Question: Author a descriptive caption for the visualization shown.
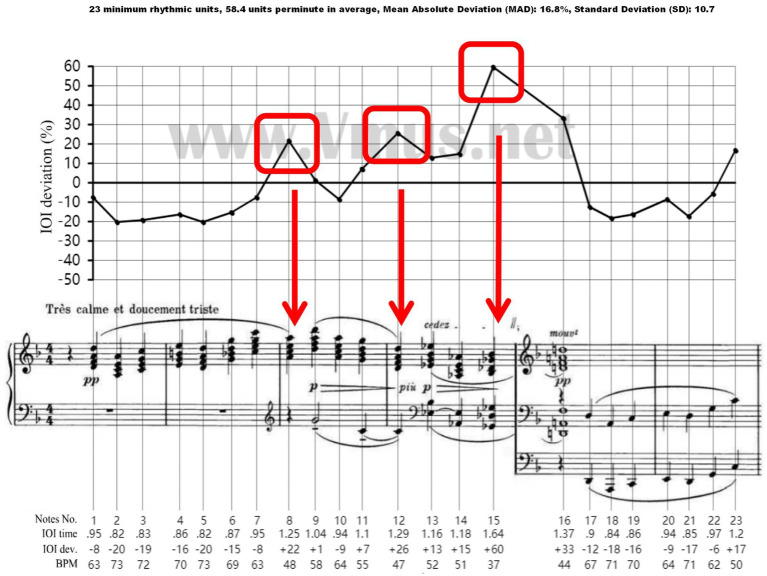
Answer: Arturo Benedetti Michelangeli “Approaching” theme IOI deviation curve.